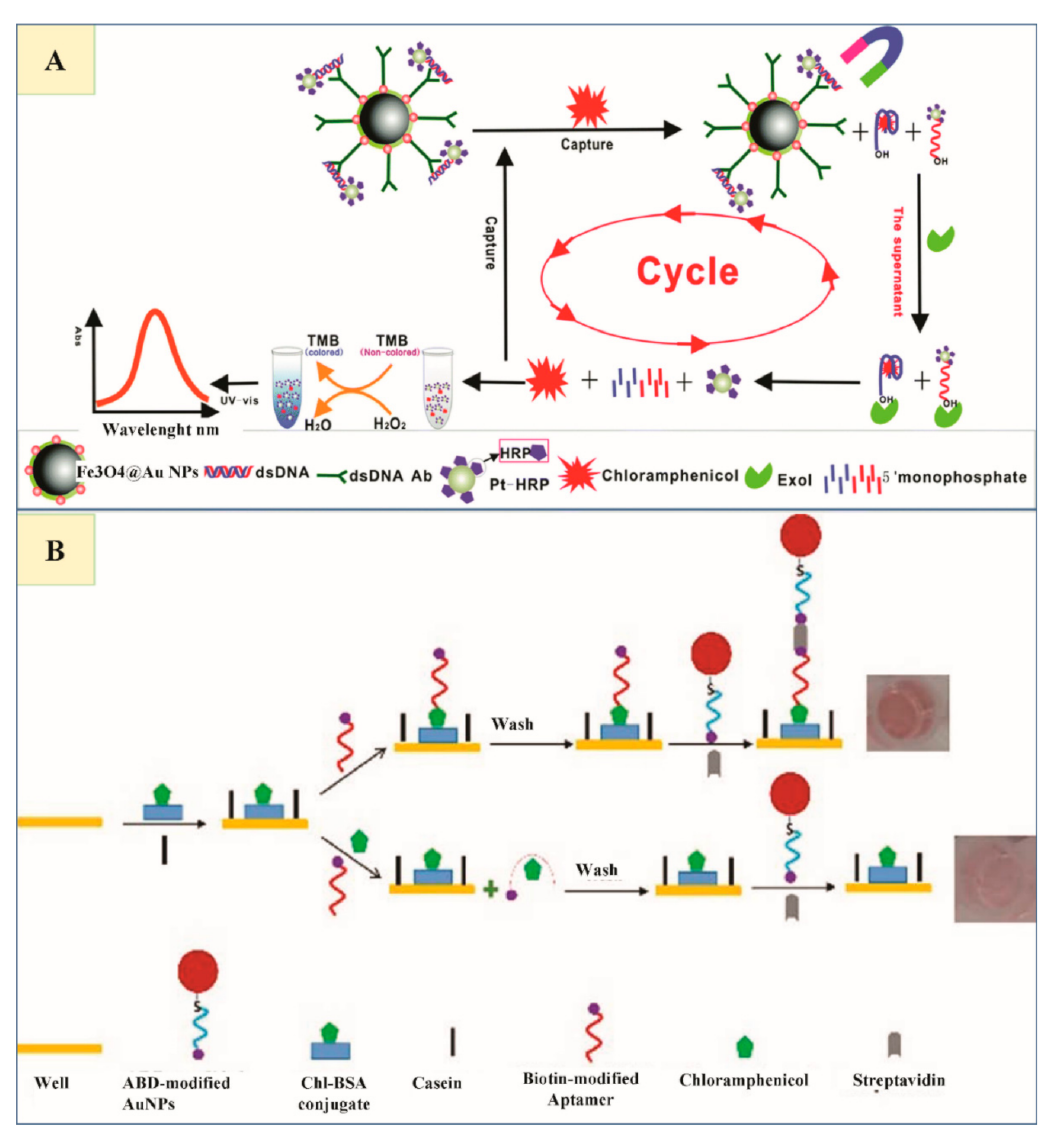
Figure 4. ( A ) Illustration of the detection processes related to color change based on chloramphenicol (CAP) presence or absence (Reproduced with permission from [78] © 2015 Royal Society of Chemistry). ( B ) Schematics showing CAP detection based on AuNPs colorimetric method. In the absence of target, the sandwich aptasensor results in bright red color. In the presence of CAP, modified AuNPs cannot bind to the well, with a subsequent pale red color change (Reproduced with permission from [77] © 2016